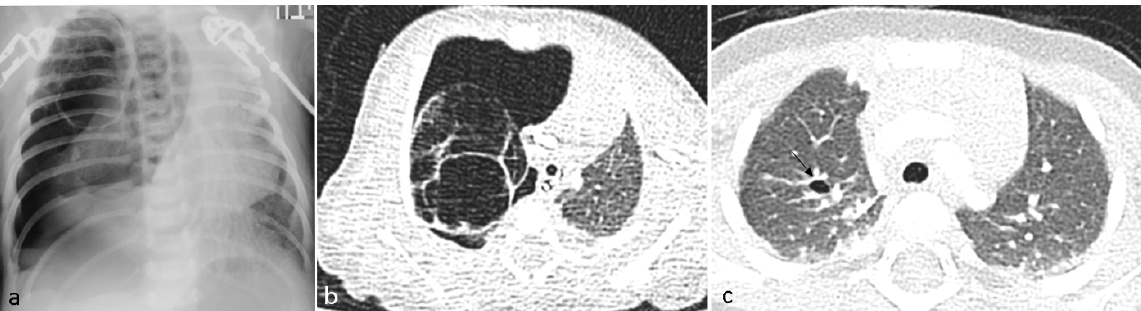
Figure 1. Six-day-old infant with respiratory distress. ( a ) Chest X-ray on day two of life: cystic lesion and tension pneumothorax on the right. ( b ) Chest CT without IV contrast performed on the same day, axial image: multicystic lesion and adjacent pneumothorax on the right hemithorax. ( c ) Chest CT performed 9 months later, with tiny cystic lesion on the right (arrow).